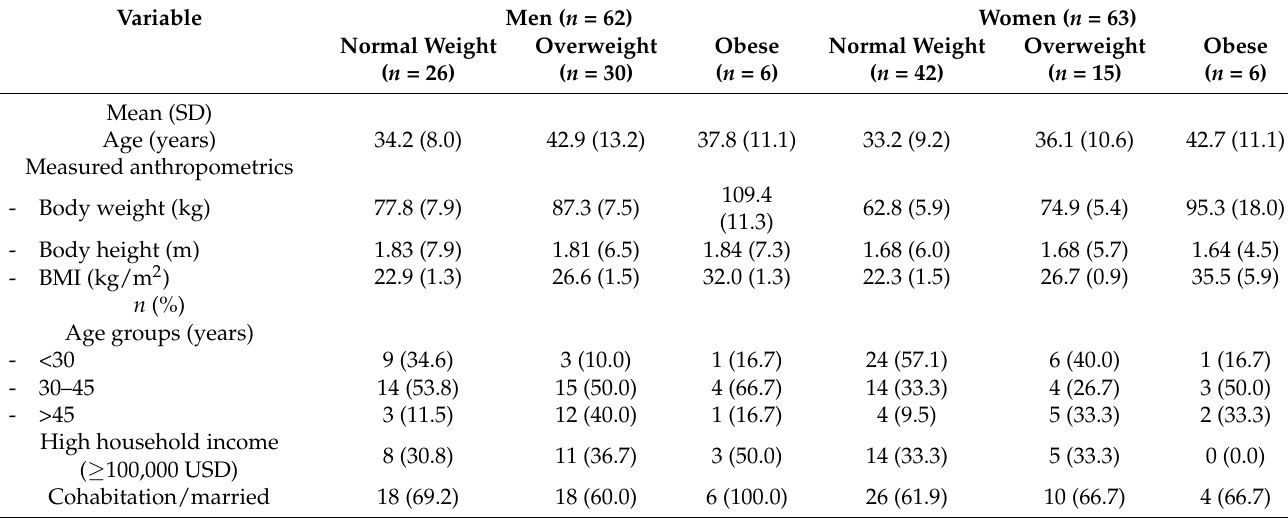
Table 1. General characteristics of the participants by measured BMI (kg/m 2 ) * category. Results are presented as mean and (standard deviation, SD) or number and (percentage,